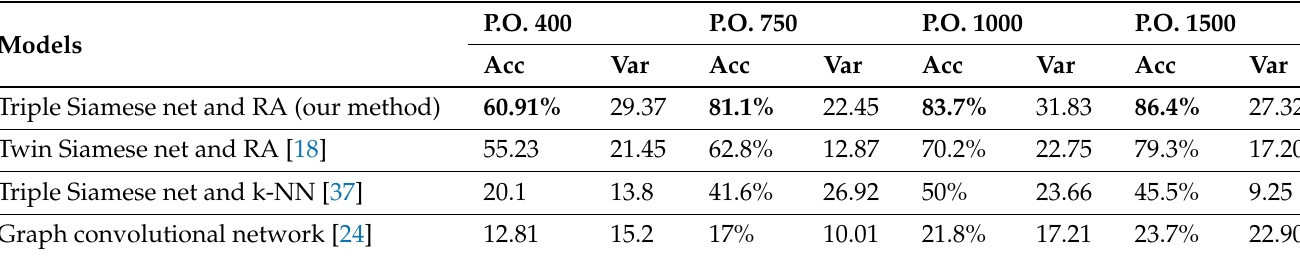
Table 1. Accuracy comparison of our model with other models for different partial-observation (PO) sizes. Note: RA, recover algorithm; k-NN, k-nearest neighbors.